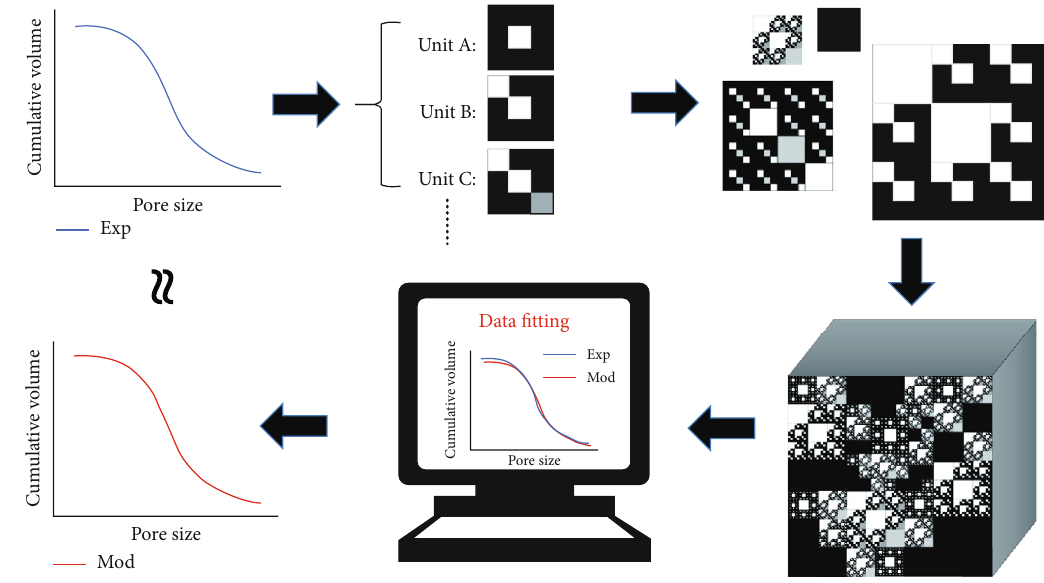
Figure 4: IFU procedure for the reproduction of porous microstructures (redrawn and modi fi ed based on an image from